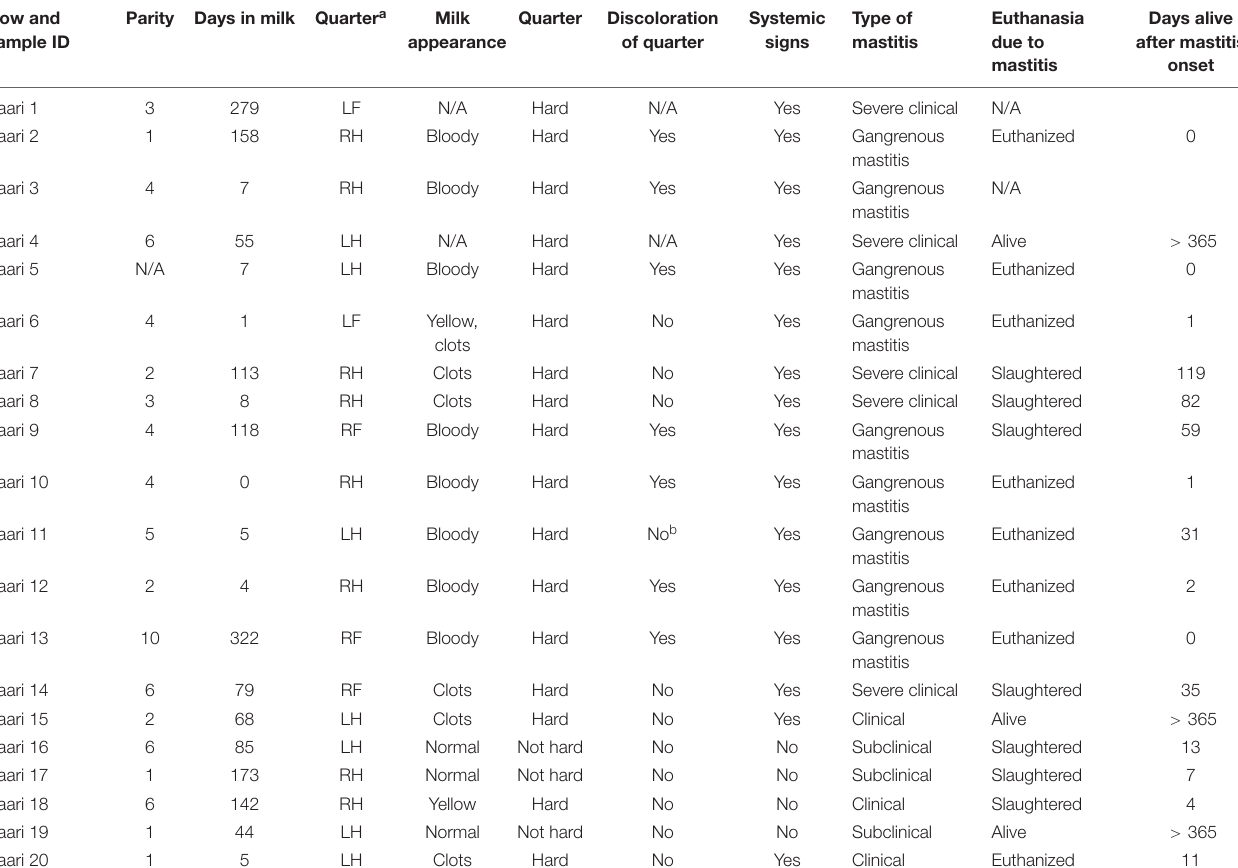
TABLE 1 | Staphylococcus aureus isolates included in the study. Cow and sample